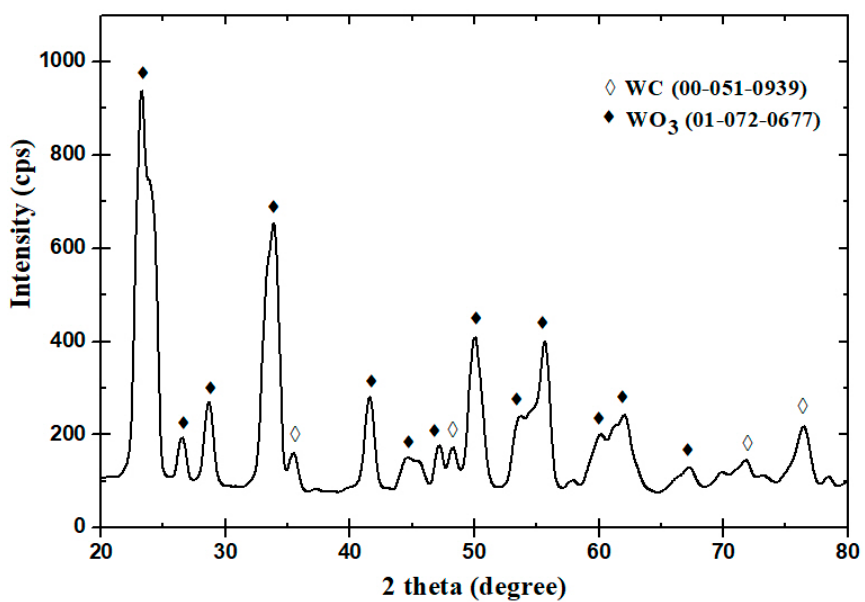
Figure 9. XRD spectrum of the WC sample, showing the intensity measured for the resulting compound after the TGA test in comparison to the database spectrum of tungsten oxide (WO 3 ).